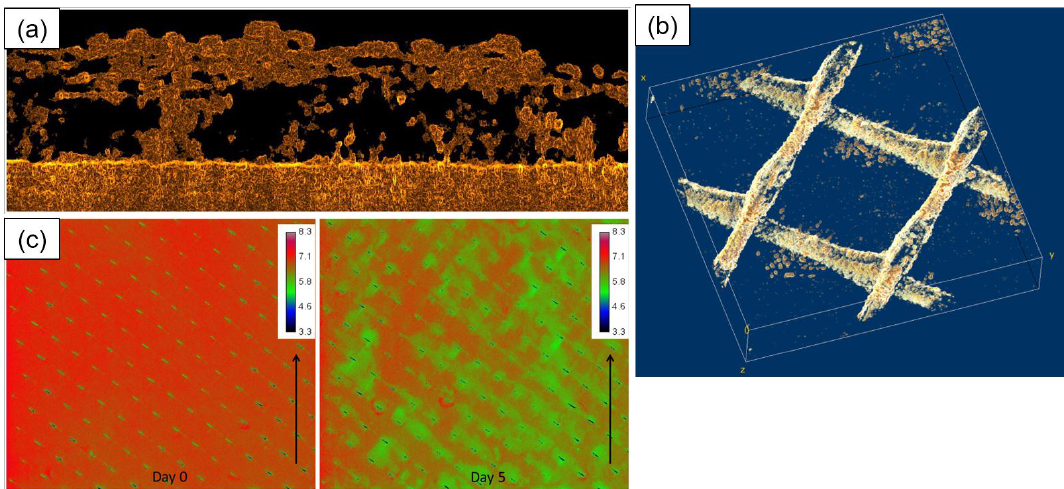
Figure 8. ( a ) Optical coherence tomography (OCT) 2-D image of a grown biofilm on a membrane surface without feed spacer in an area of a 3.83 mm × 0.85 mm. The membrane is shown at the bottom of the figure. The biofilm had a heterogeneous structure containing voids; ( b ) 3-D reconstruction of a biofilm grown on the surface of a membrane and feed spacer in a flow cell; the image was obtained after processing OCT 3-D scans in an area of 6 mm × 6 mm × 1.08 mm. Spacer filaments contained most of the biomass detected; ( c ) Spatial distribution of oxygen concentration (mg/L) at the inlet side of the MFS on day 0 and after 5 days of biofilm development. The arrow indicates the water flow direction. The scale bar represents oxygen concentration (mg/L). The imaged area is 4.0 mm × 3.5 cm. Biofilm accumulation started on the feed spacer. Reprinted from [96], with permission from Taylor & Francis Online.